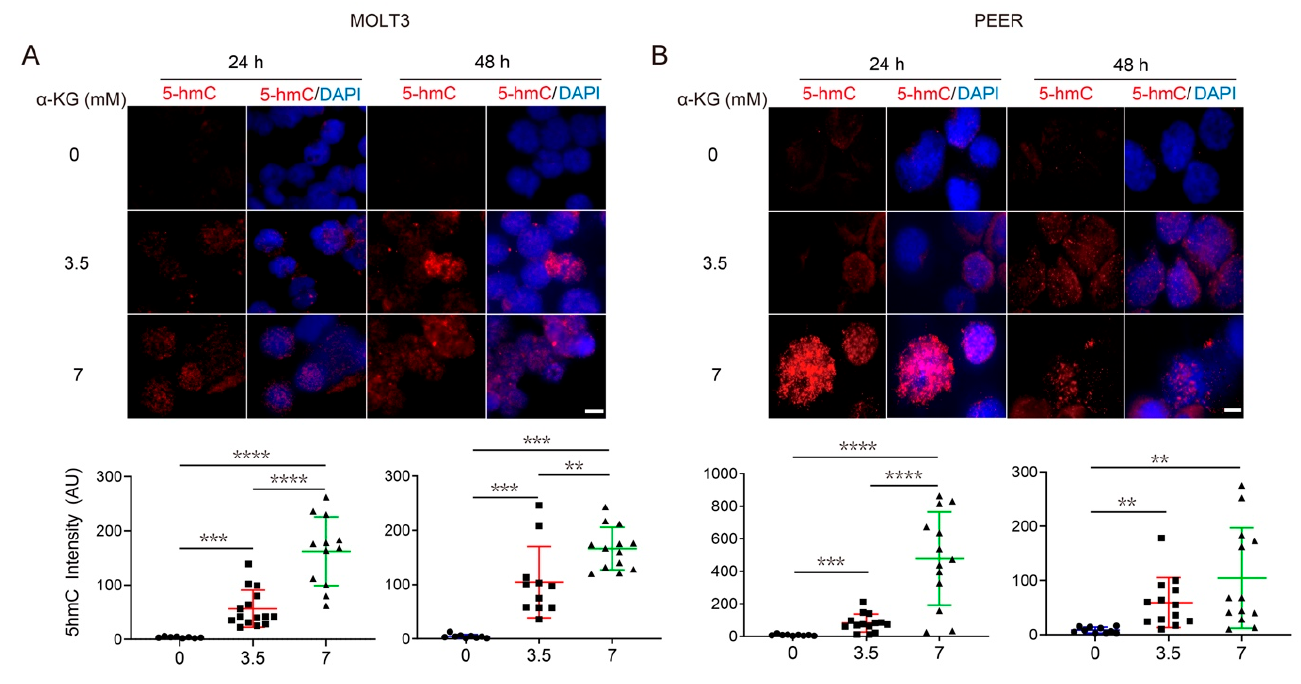
Figure 4. α -KG treatment in T-ALL cells increases DNA demethylation in a concentration-dependent manner. ( A , B ) 5hmC staining in MOLT3 ( A ) and PEER ( B ) cells after 24 and 48 h of treatment with 0, 3.5, or 7 mM of α -KG. DAPI (blue) counterstaining indicates the intranuclear location. The quantification of relative 5hmC fluorescence (red) is presented as the mean ± s.e.m., and an unpaired two-tailed t -test is used for statistical analysis. Scale bar = 10 µ m. ** p < 0.01, *** p < 0.001, **** p < 0.0001.